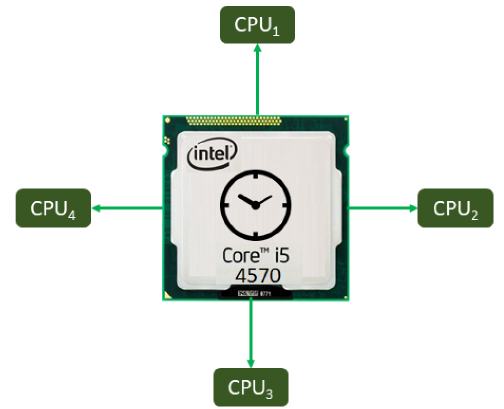
Figure 15. Time base of the microprocessor Intel i5 4570.